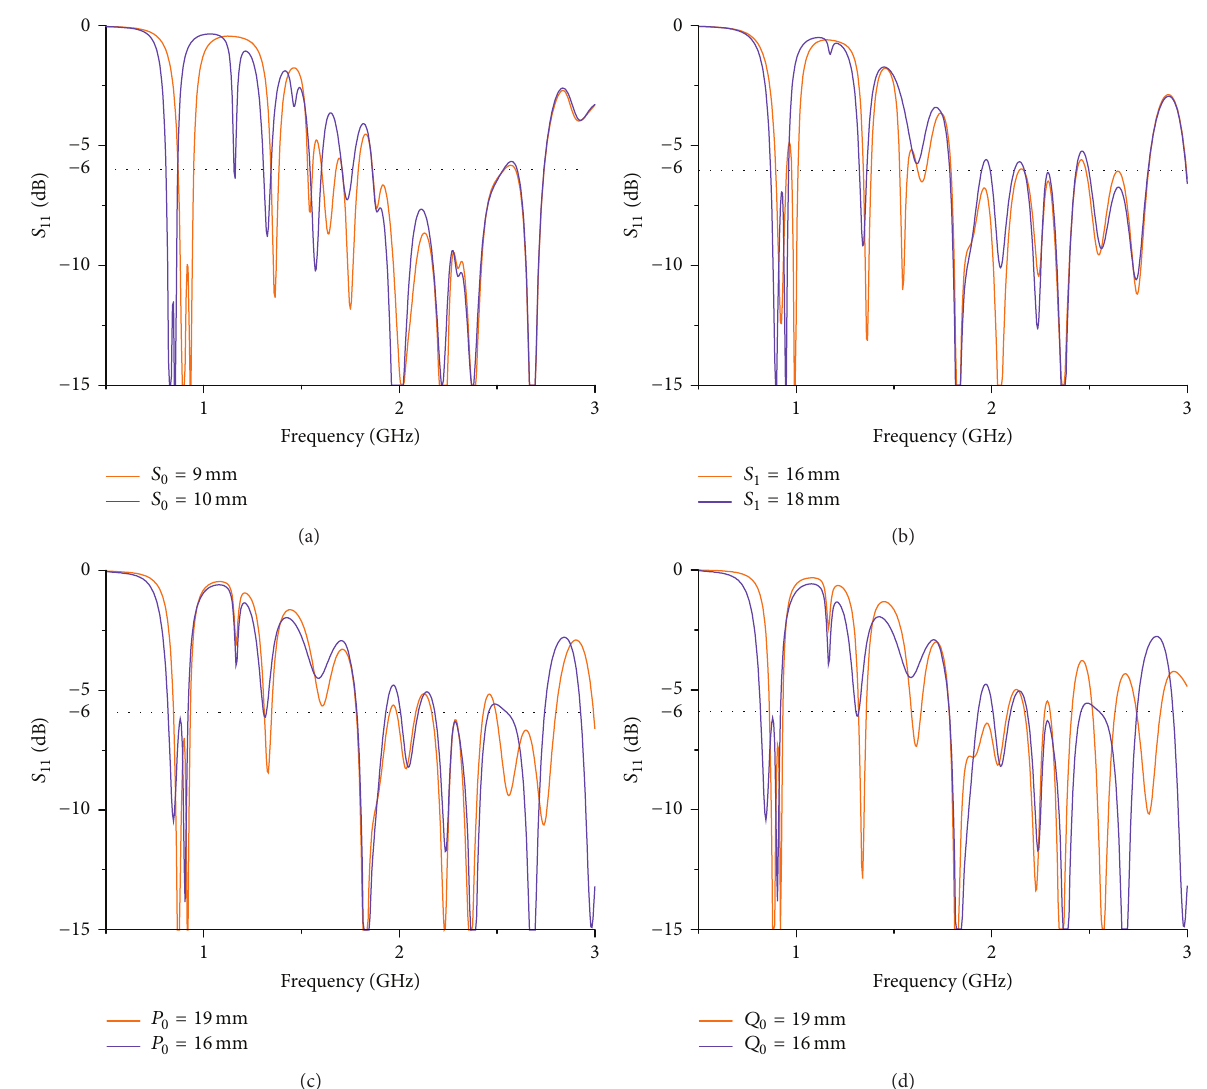
Figure 2: Effects of changing the lengths of (a) 𝑆 0 and (b) 𝑆 1 on 𝑆 11 and also the effects of the change in the positions of (c) 𝑃 0 and (d) 𝑄 0 on 𝑆 11